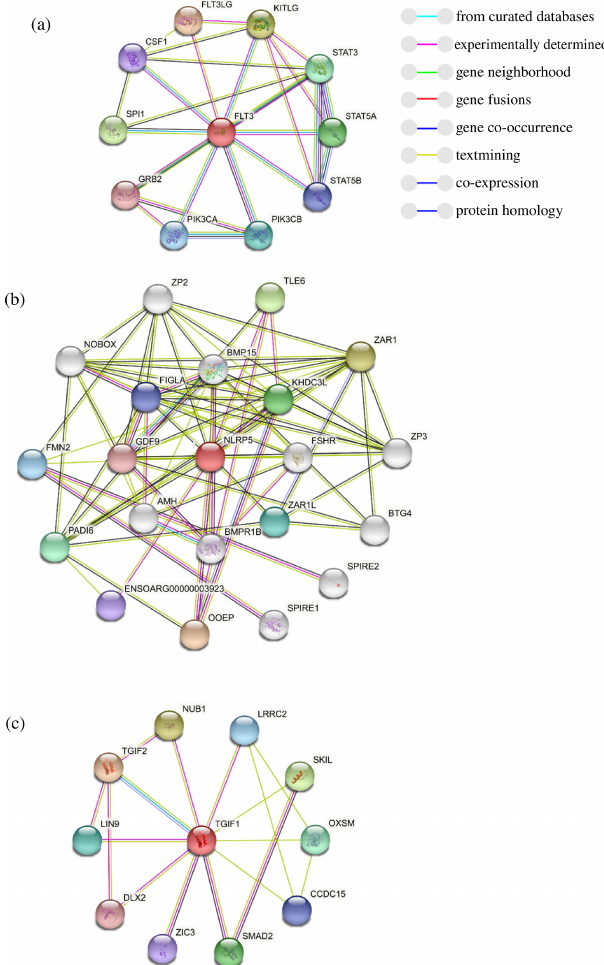
Figure 4. The prediction of the protein interaction networks of FLT3 (a) , NLRP5 (b) , and TGIF1 (c) , based on the STRING